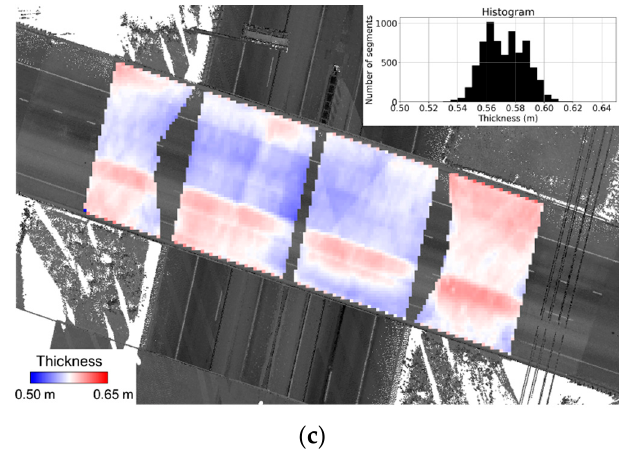
Figure 18. Bridge deck thickness estimates shown as a heat map using the ( a ) TLS, ( b ) PWMMS-HA, and ( c ) PWMMS- UHA datasets.